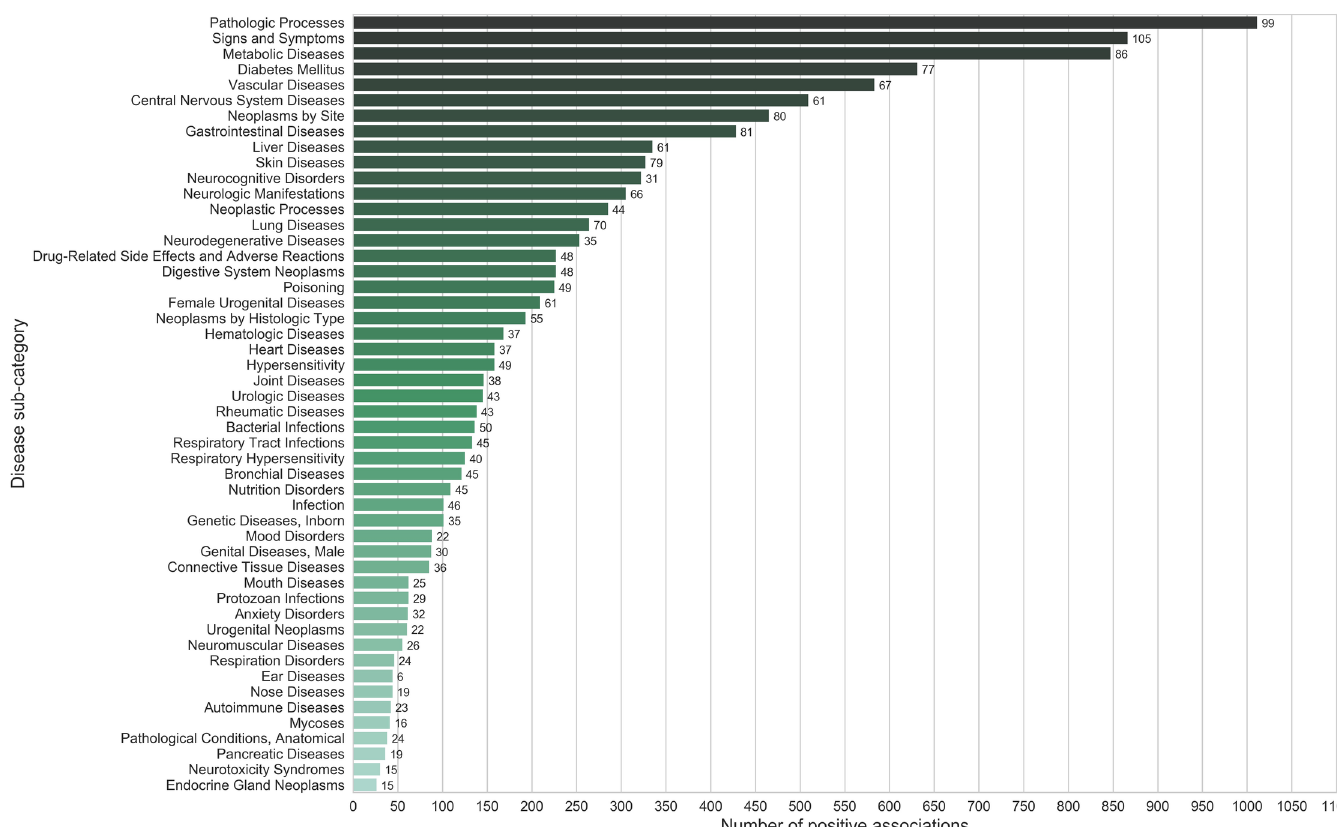
Fig 6. Disease categories (First level of MeSH hierarchy) ranked according to the number of positive associations with spices. Numbers shown against the bars indicate the ‘number of spices’ linked with each of the associations. The number of positive disease category associations for spices outnumber those with negative associations (Fig 7) further confirming the benevolent health effects of